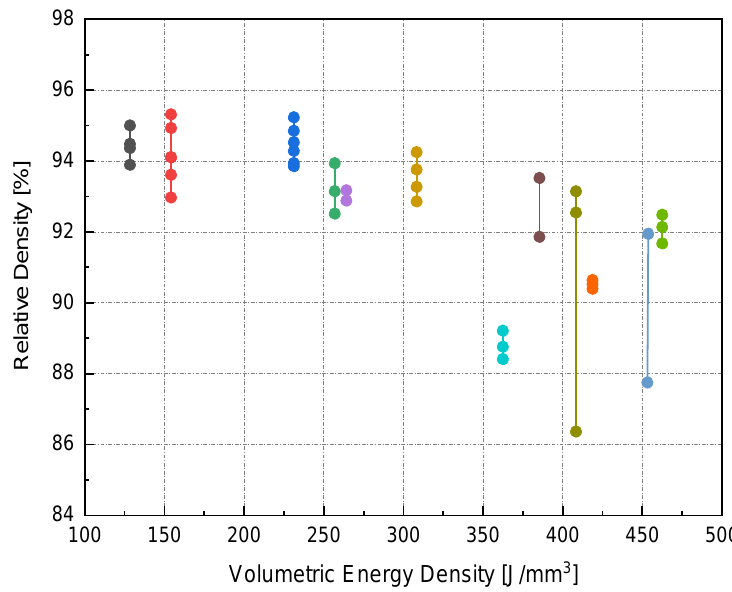
Figure 5. RD variance for groups of identical E v .